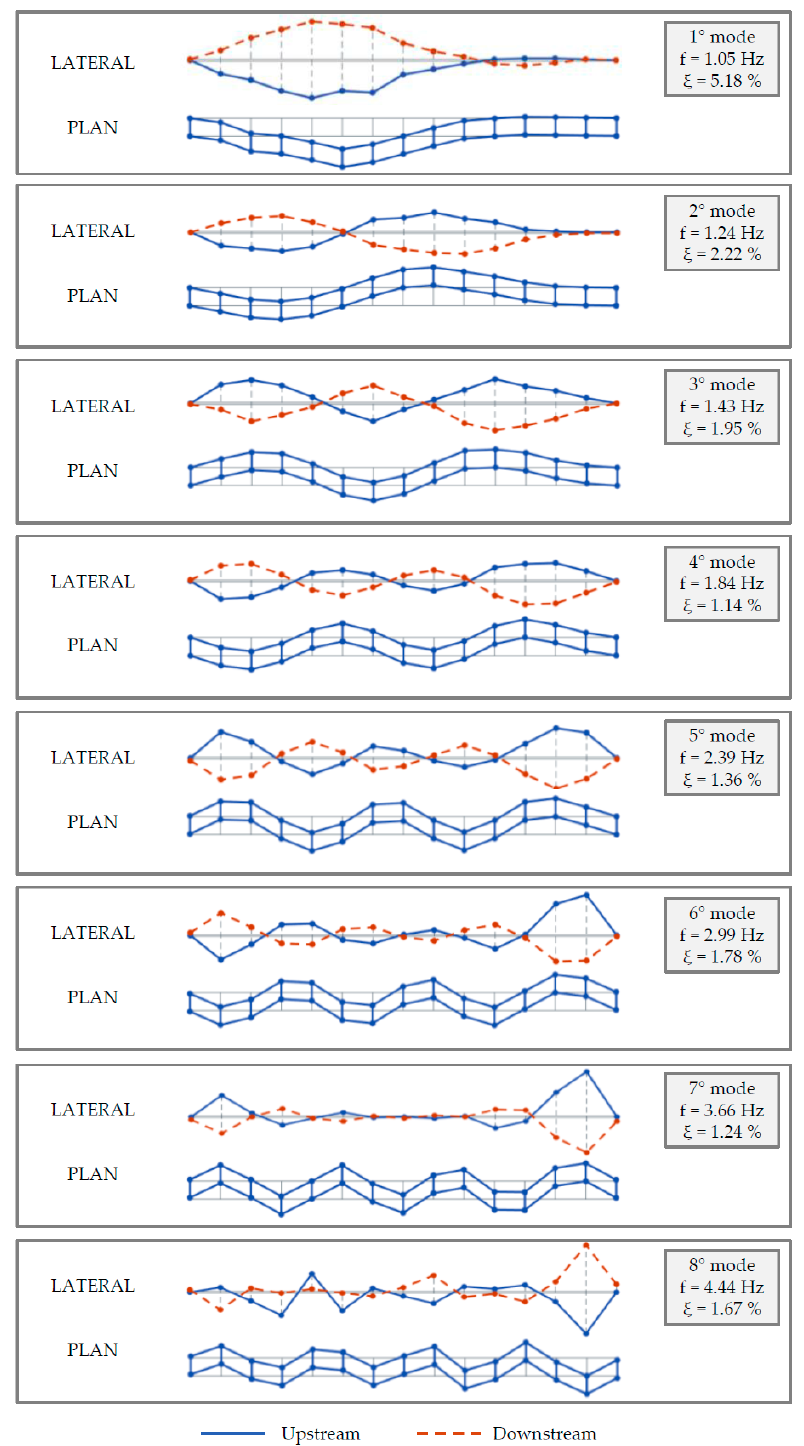
Figure 9. Experimental modal parameters obtained from OMA for the B2 bridge.